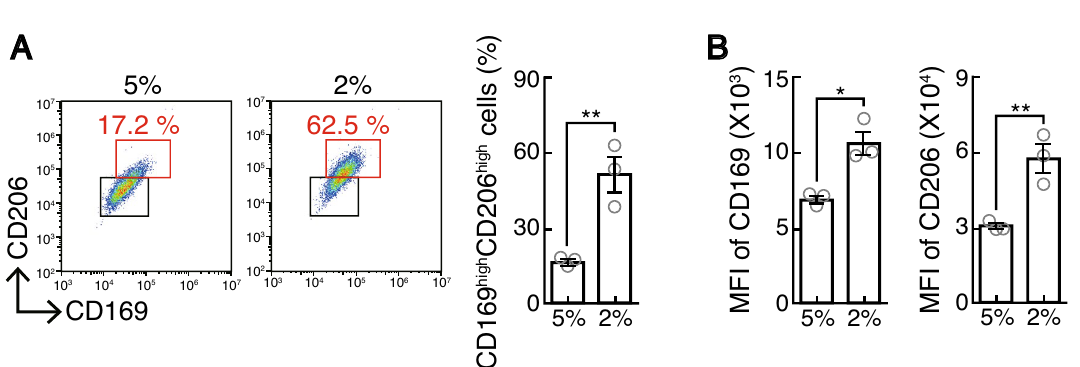
Figure 4. Effect of physiological hypoxia on monocyte differentiation. ( A ) Interleukin (IL)-4-treated bone marrow-derived monocytes/macrophage precursor cells (BMMs) were stained for CD115, CD169 and CD206. The CD169/CD206 profiles of CD115 + cells are shown. Numbers indicate the proportion of each population within the red-colored square. The percentage of CD169 + CD206 + cells cultured under the conditions of 5% and 2% oxygen (n = 3, right). ( B ) Mean fluorescent intensity (MFI) of CD169 and CD206 of CD115 + cells (n = 3). Data denote the mean ± s.e.m. * P < 0.05; ** P < 0.01, unpaired two-tailed Student’s t effect of physioxia perturbation on M2 macrophage polarization by applying the in vivo information on oxygen tension of monocytes to in vitro cell culture. In bone marrow, there are two types of bone resident macrophages; bone marrow macrophage and osteal macrophage. Both types of macrophages express CD169, but CD206 is expressed in osteal macrophage, but not in bone marrow macrophages 17 . We evaluated the CD169 and CD206 expression levels in vitro by culturing BMMs under the oxygen concentration of 5% and 2%. We determined that the expression levels of both CD169 and CD206 were significantly enhanced under 2% oxygen compared to those under 5% oxygen (Fig. 4A,B). These results suggest that monocyte differentiation was affected within the physiological range of oxygen tension.